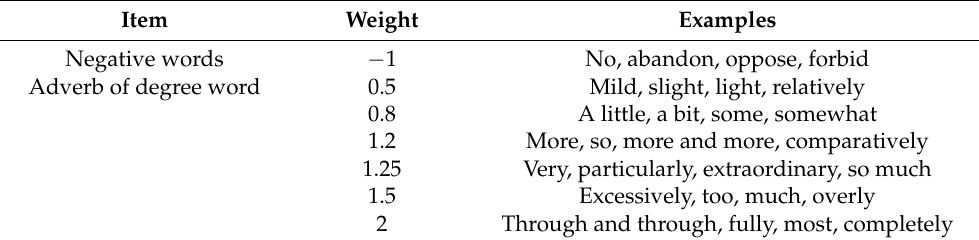
Table 3. Examples of negative word and adverb of degree word